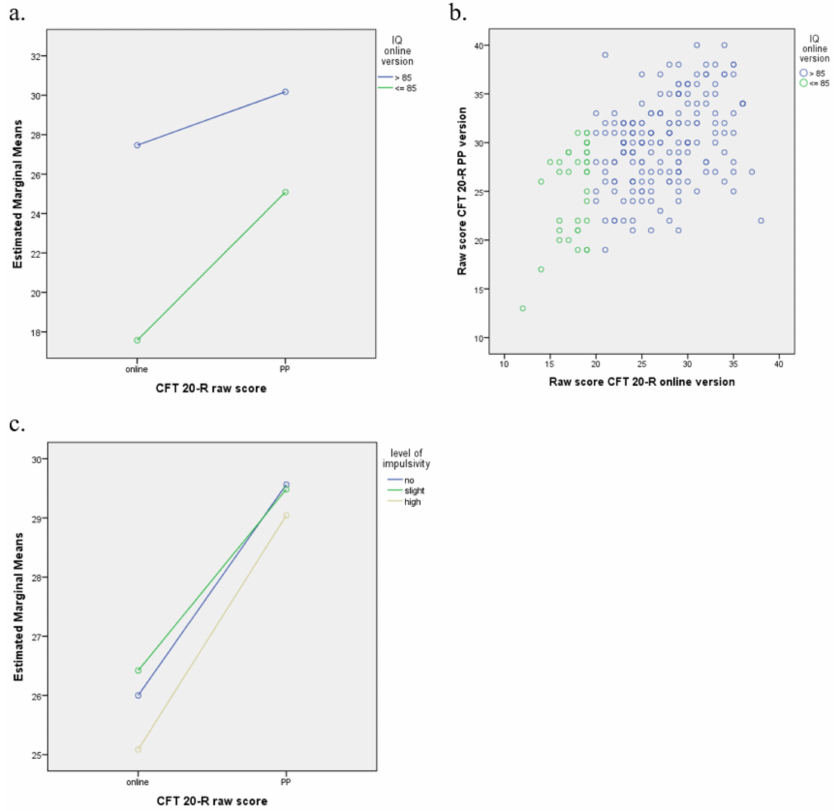
Figure 2. Raw scores for the Paper-Pencil (PP) and online versions of the CFT 20-R for children with different levels of intelligence (line chart ( a ) and scatter plot ( b )) and impulsivity (line chart ( c